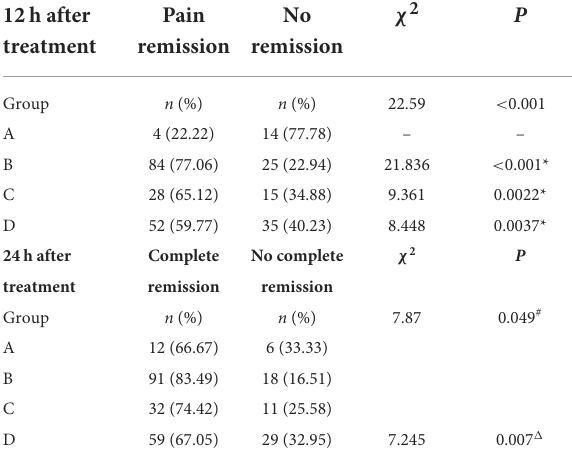
* ComparedwithgroupA. 1 ComparisonbetweengroupBandgroupD. # Comparisonamongfourgroups.